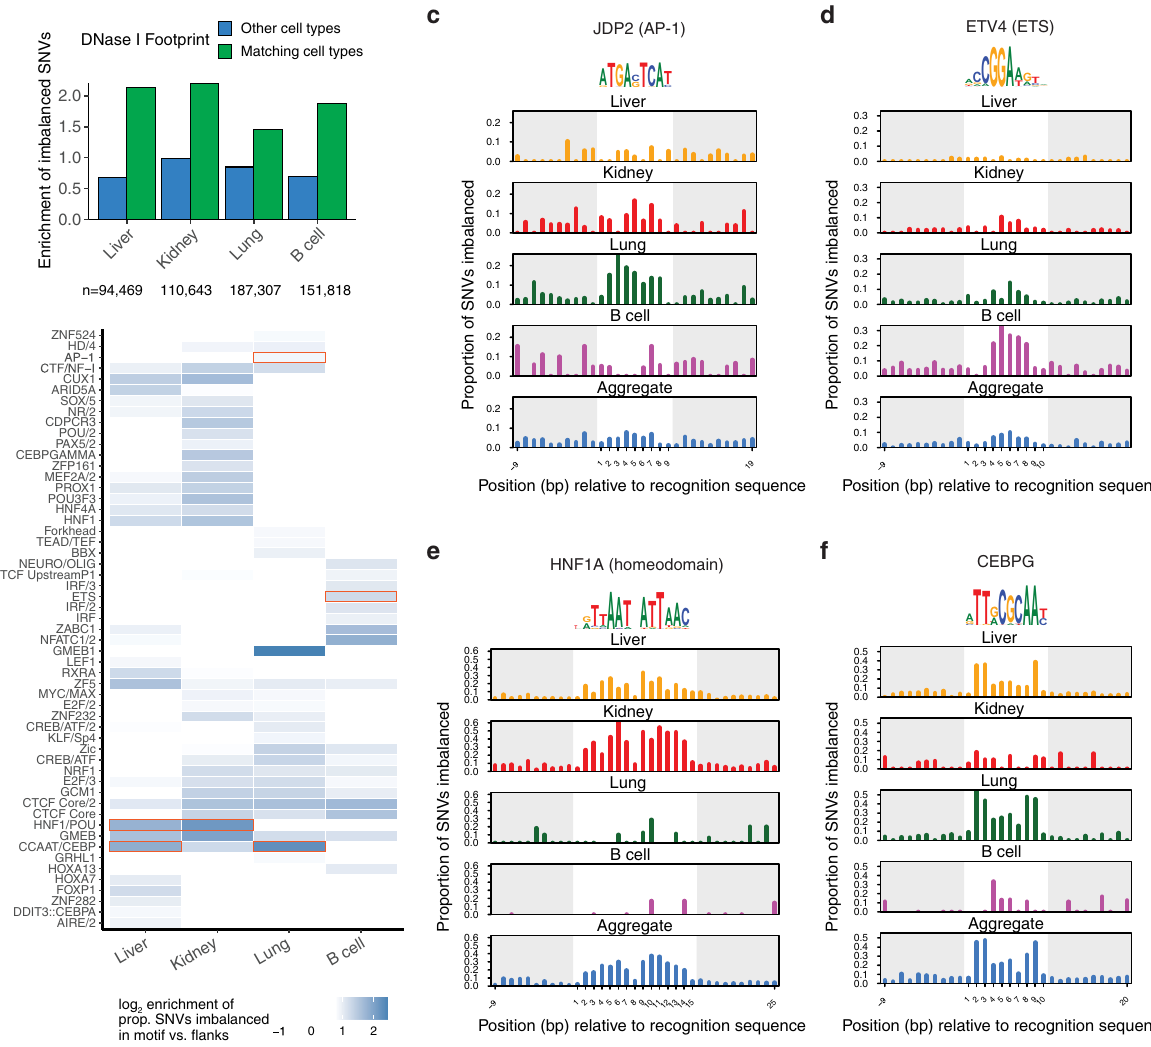
Fig. 5 Cellular context-sensitive analysis of variation affecting TF occupancy. a Enrichment of imbalance called in each cell type for overlap with DNase I footprints in matching cell type (green) or in other cell types (blue). b Cell-type-speci fi c enrichment of SNVs in motif for TFs. Shown are TF families with greater than twofold enrichment in at least one cell type. c – f Analysis of variation affecting TF occupancy across cell/tissue types for JDP2, ETV4, HNF1A, and CEBPG